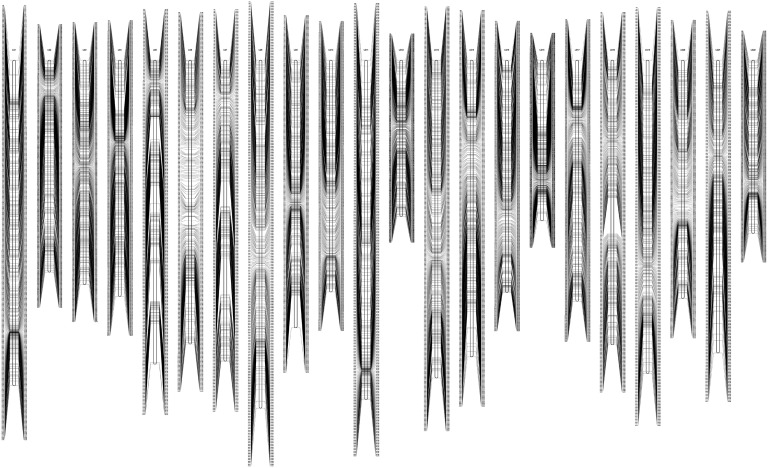
High-density genetic linkage map of turbot (S. maximus) SNPs.Linkage group name and number are placed above each linkage group, for example, LG2 represents the second linkage group (LG). Numbers on the left are recombination fraction (RF) between the uppermost SNP mapped in an LG to any linked SNP marker in Kosambi’s distance in the same LG. For example, the left third number 2.796cM in LG3, represents the genetic distance between the uppermost SNP marker SM_670 and the third SNP marker SM_672. Linked SNP’ names are on the right, SM Scophthalmus maximus, and the number is the order of SNPs 1 to 6, 647.